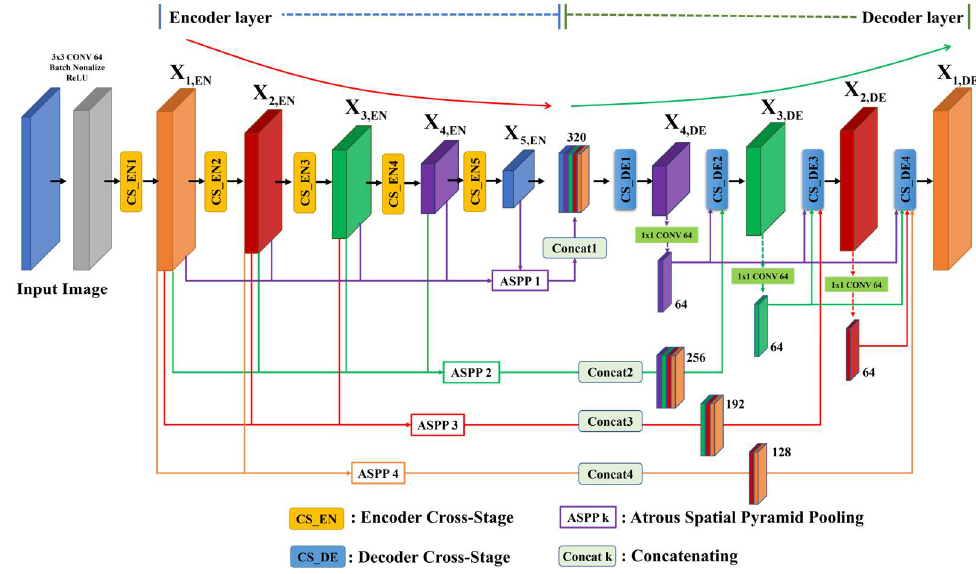
Figure 8. The Structure of the proposed CNN with multi-layer ASPP and